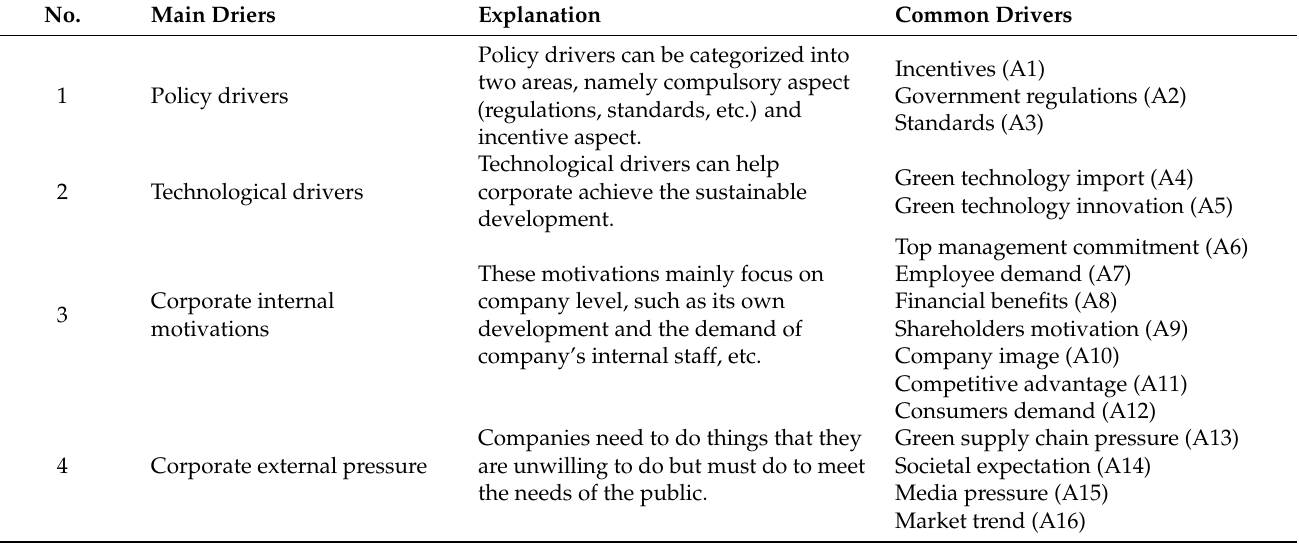
Table 1. Common drivers of corporate environment